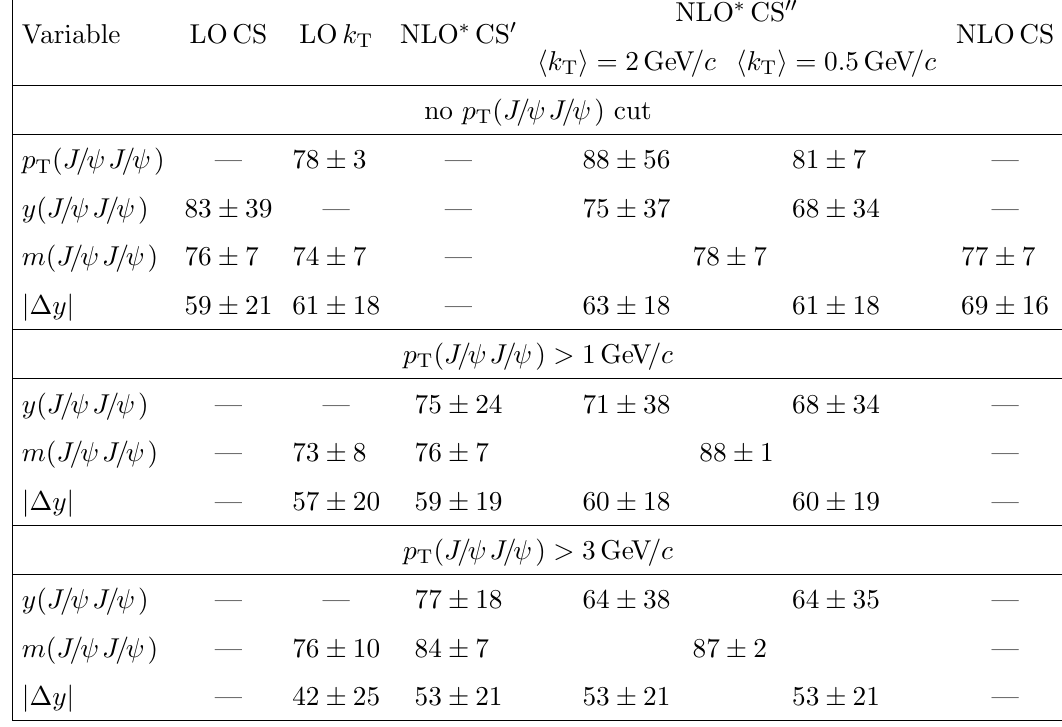
Table 3. Percentages of the DPS component, f DPS , determined with the simple two-component